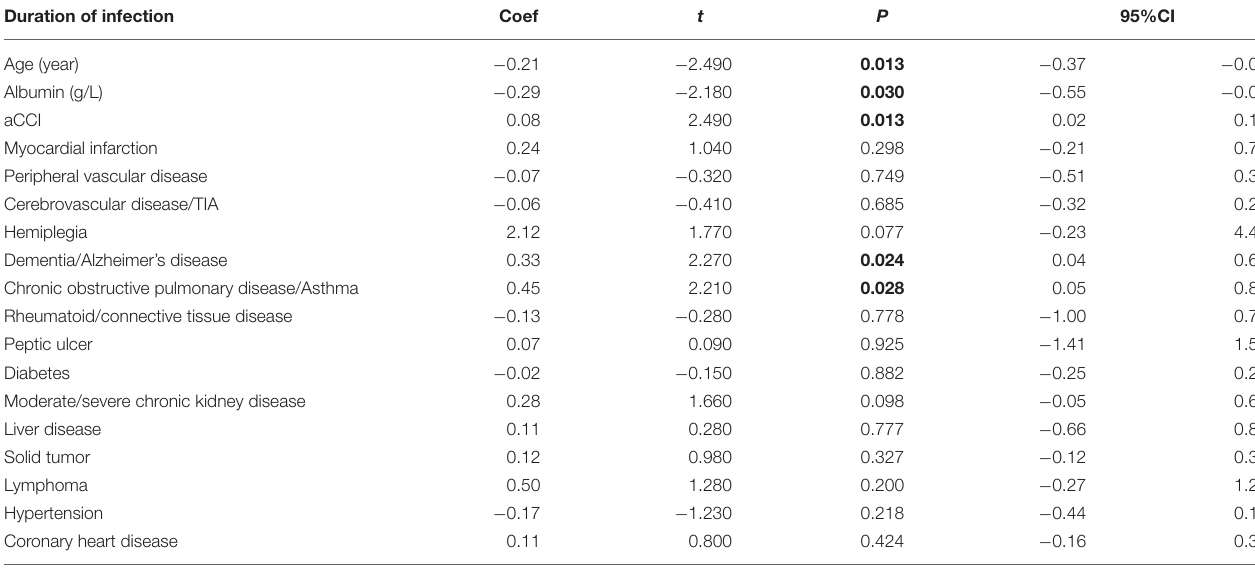
TABLE 2 | Aging-related risk factors (age, nutrition, and comorbidities) on the outcome of pneumonia in all infected patients. Duration of infection Coef